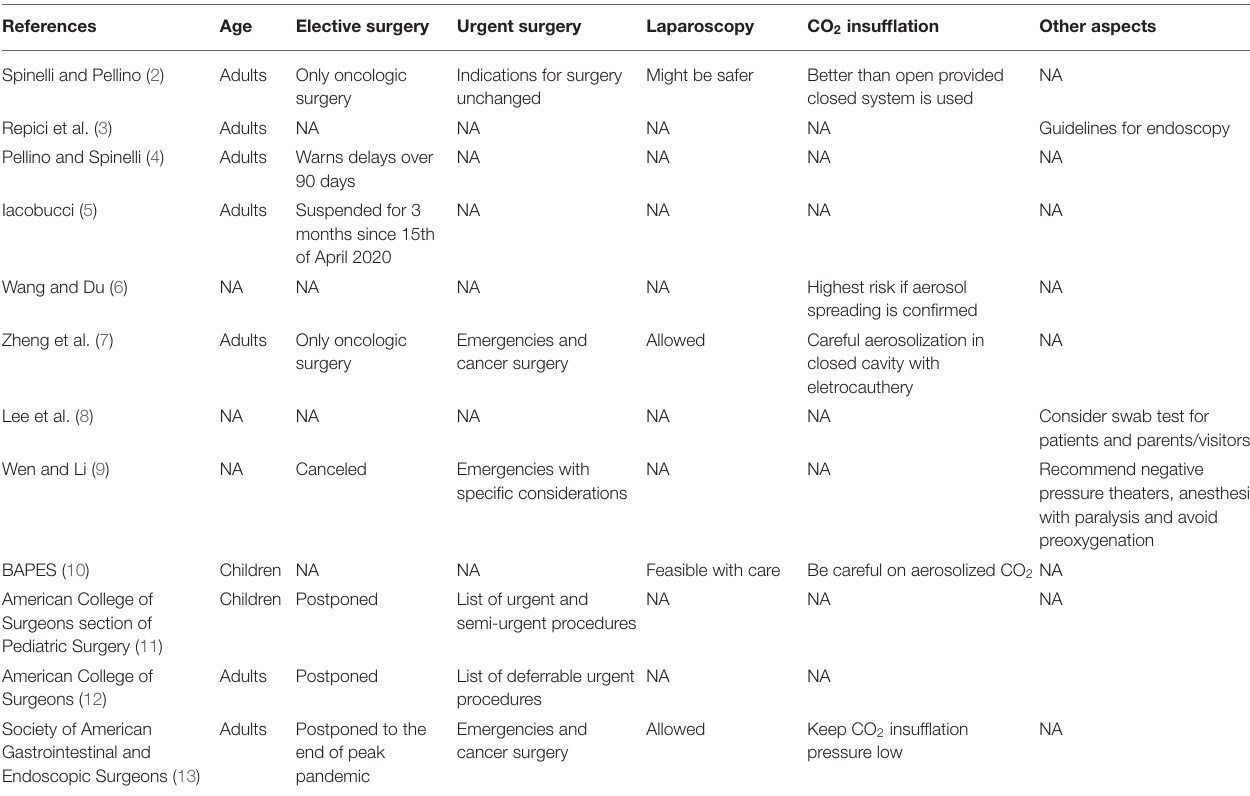
TABLE 1 | List of papers included in systematic review (rows) and areas of assessment